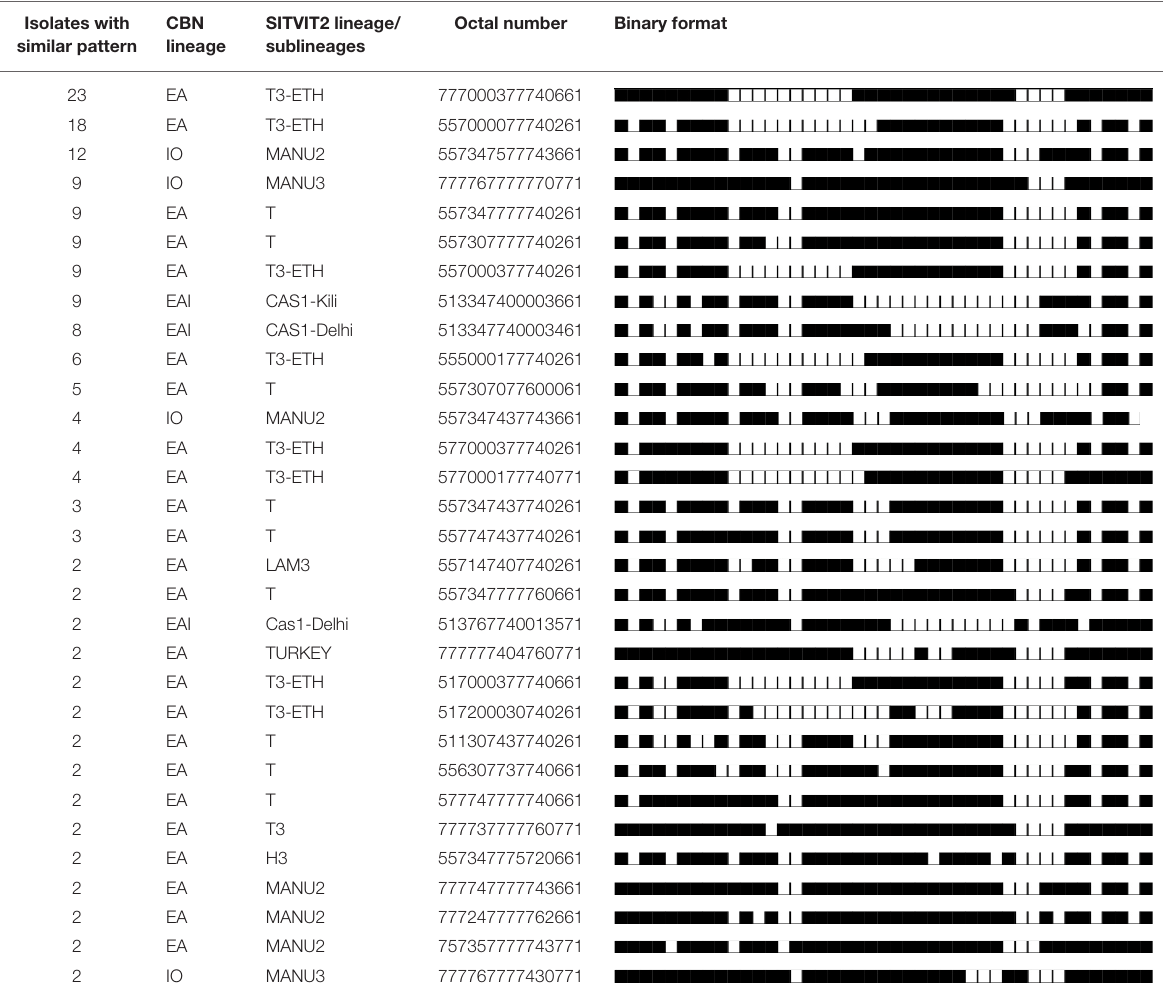
TABLE 2 | The spoligotype patterns of clustered spoligotypes or strains ( n = 31) and their corresponding lineages or sublineages, Oromia, Ethiopia, 2020. SIT Isolates with CBN SITVIT2 lineage/ Octal number Binary similar pattern lineage sublineages